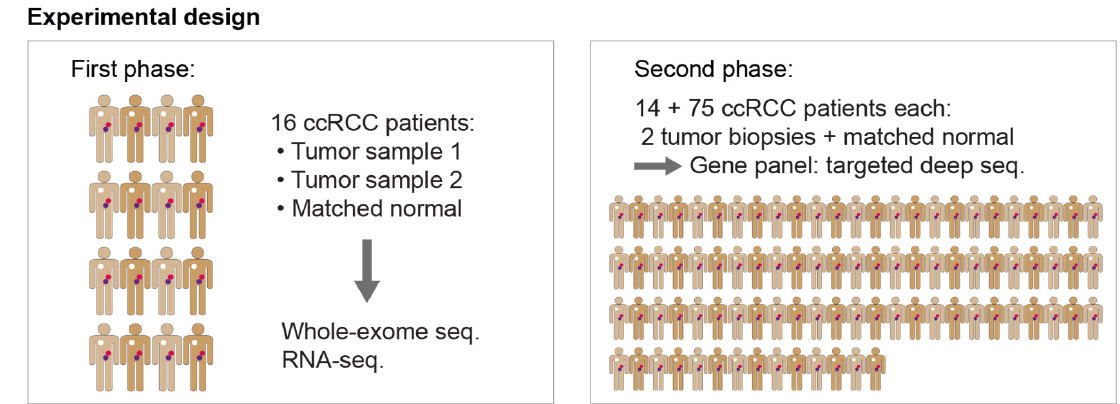
Figure 1. Experimental design. The first phase includes 16 clear cell renal cell carcinoma (ccRCC) patients of which two spatially separated biopsies from the primary tumour and a matched normal sample were collected. Whole-exome sequencing and transcriptome sequencing was performed and the detected mutations informed the selection of genes for the panel of the second phase. The second phase includes an extended cohort of patients and the selected genes were targeted with higher coverage. From a total of 89 patients, we analysed two spatially separated tumour biopsies and a matched normal sample per patient. Fourteen of the patients in this panel data set were also among the 16 from the first